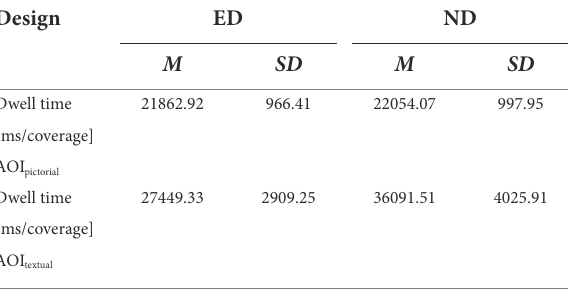
TABLE 3 Mean dwell times and standard deviations for design ( n =